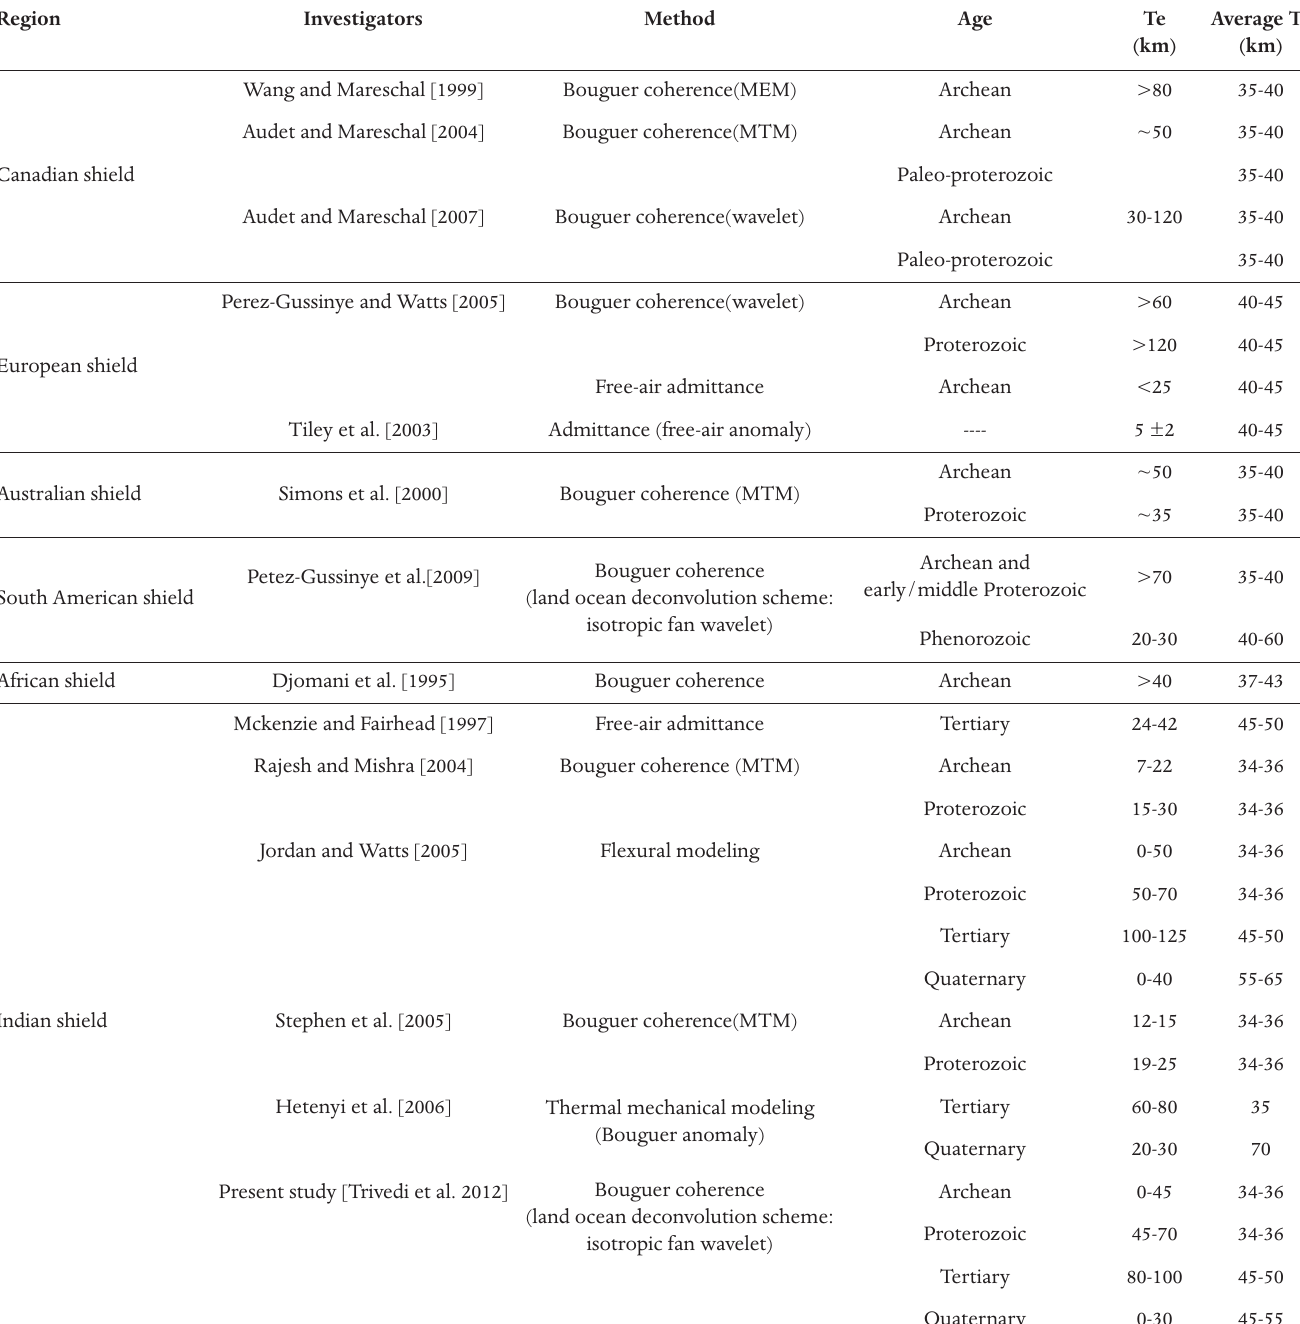
Table 1. Estimation of the elastic thickness (Te) at the continental cratons and the average crustal compensation